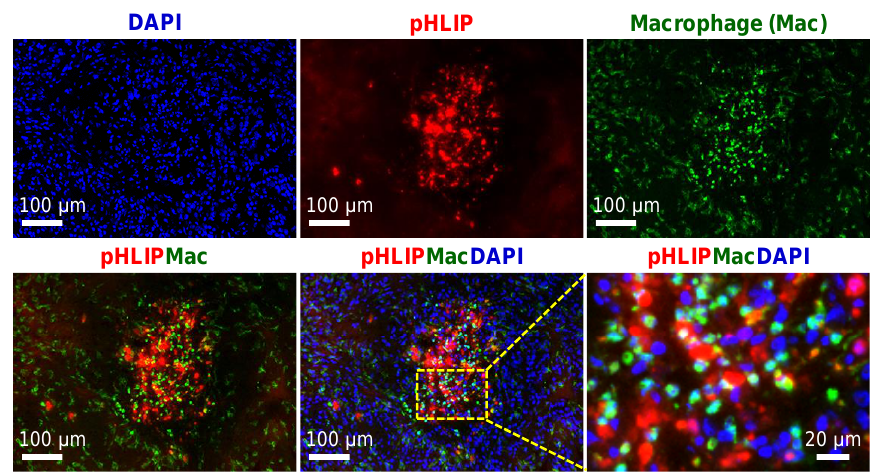
Figure 7. Spatial relationship between the intratumoral distribution (ITD) of pHLIP and macrophages. pHLIP distribution (AF546-pHLIP, red), CD11b-stained macrophages (green), and DAPI-stained nuclei (blue) were examined at the same sites of the same tumor sections. Shown here are images acquired from a representative high pHLIP-accumulated region in a U87MG tumor section. The red/green overlapping (yellow) is not indicated. An enlarged view of the dotted rectangle clearly shows that pHLIPs and macrophages (CD11b-positive cells) were not overlapping.